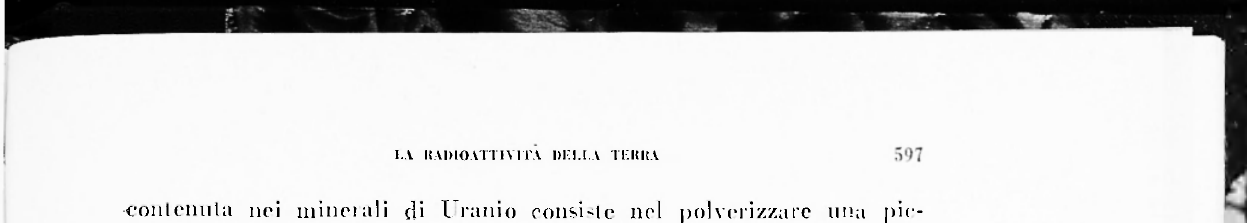
1'») si fa pa--are il ga- in